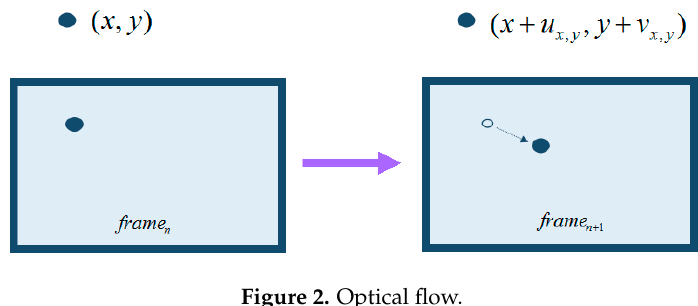
Figure 2. Optical flow.